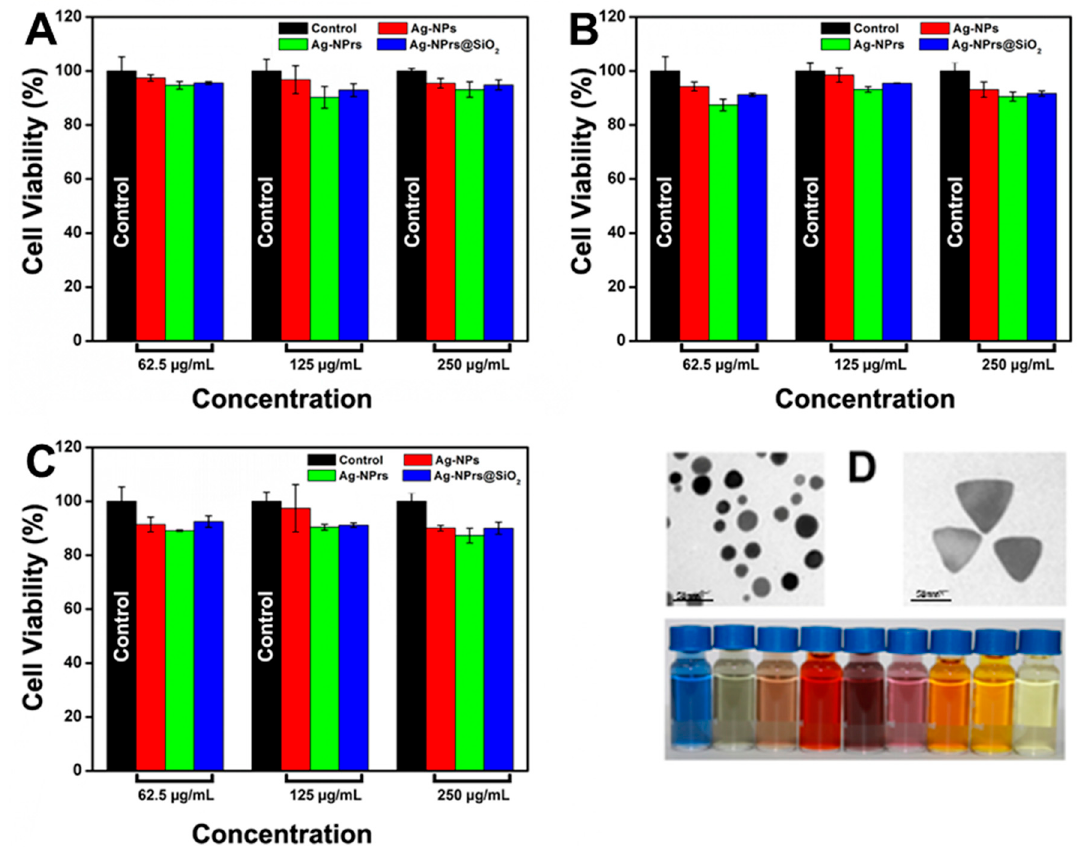
Figure 10. ( A ) The cell viability of Ag-NPs, Ag-NPrs, and Ag-NPrs@SiO 2 with 62.5 µg/mL, 125mL, and 250 µg/mL concentrations after 12 h exposure time. ( B ) The cell viability of Ag-NPs, Ag-NPrs, and Ag-NPrs@SiO 2 at the concentrations of 62.5, 125, and 250 µg/mL after 24 h exposure time. ( C ) The cell viability of Ag-NPs, Ag-NPrs, and Ag-NPrs@SiO 2 at concentrations of 62.5, 125, and 250 µg/mL after 48 h exposure time. ( D ) Overall Ag-NPrs formation TEM image and digital photo used for the cell viability assay. Cell viability assays were triplet repeats.